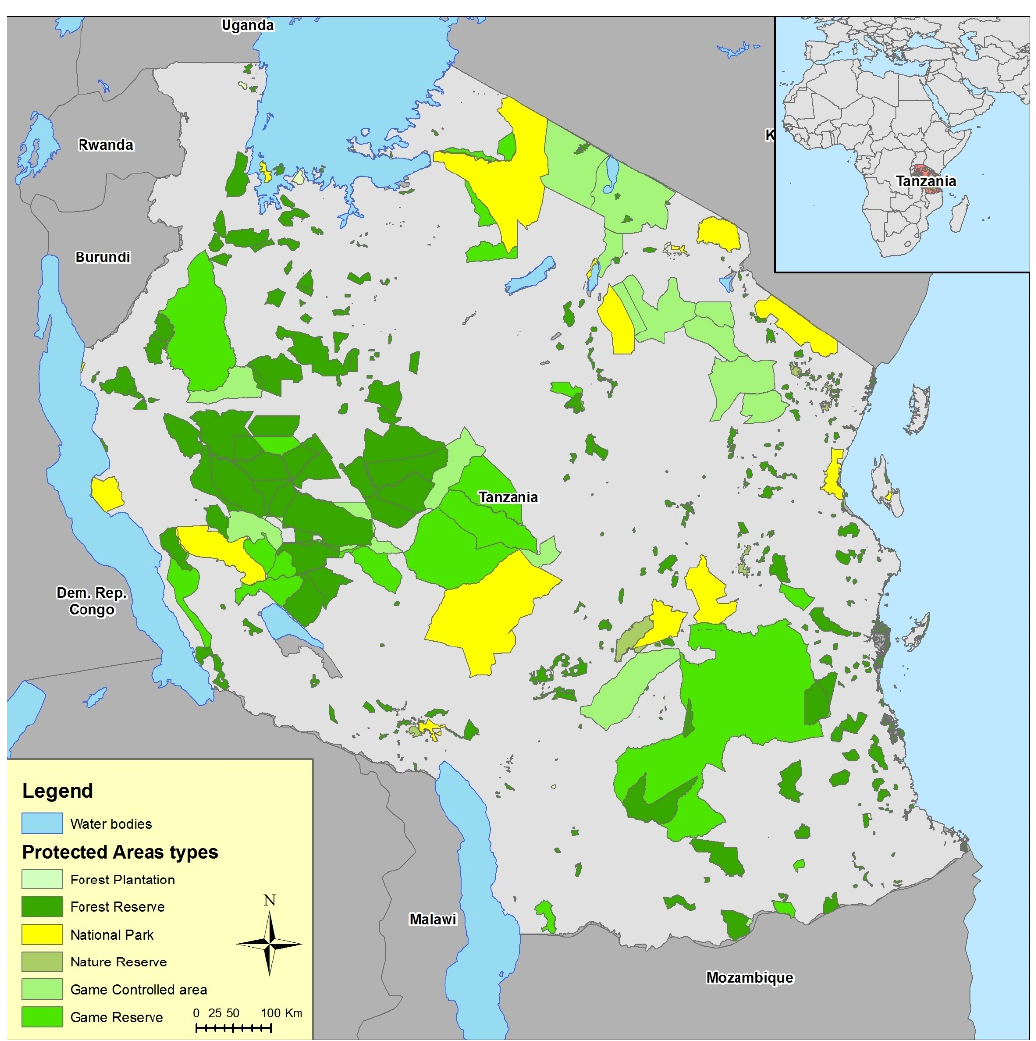
Figure 1. Location of Tanzania in Africa and Protected Areas (PAs) in Tanzania by management regimes. The different colors (except the blue which are water bodies) represent management regimes, namely (in no particular order), National Parks (NP), Game Reserves (GR), Game Controlled (GC) area, Nature Reserves (NR), Forest Reserves (FR), and Forest Plantations (FP).